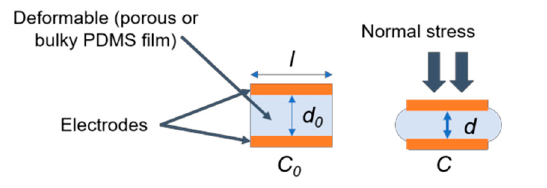
Figure 1. Principle of operation of a flexible normal pressure capacitive sensor.